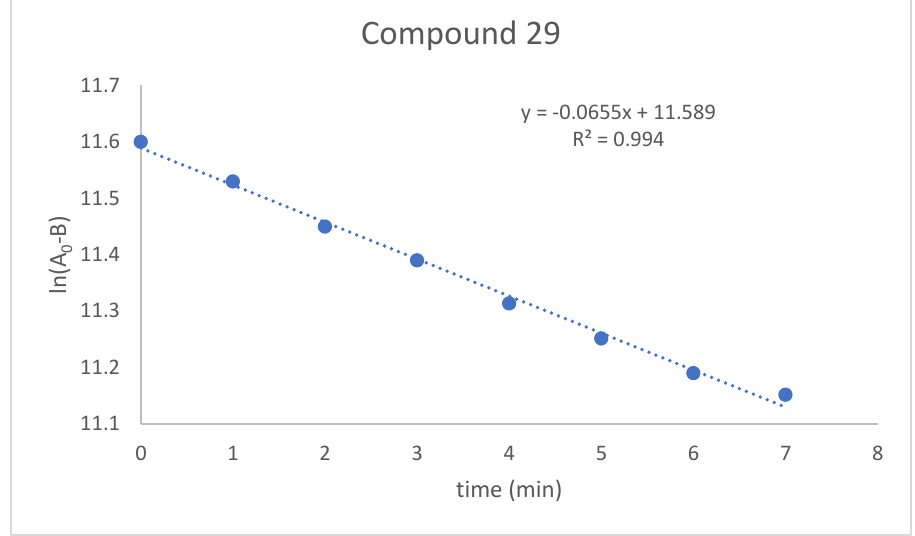
Figure 2. Pseudo first-order degradation of compound 29.